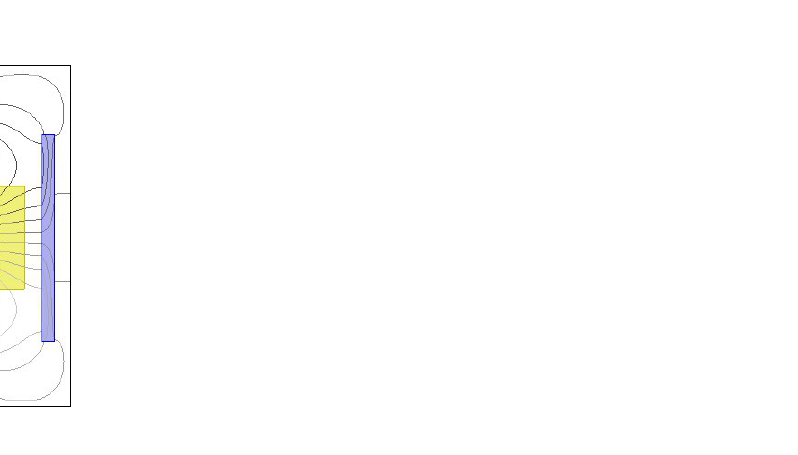
Figure 5. Exemplified model implementation in ANSYS Maxwell. The models are implemented in 2D and utilize the axisymmetric property of the configurations to result in time efficient simulations.